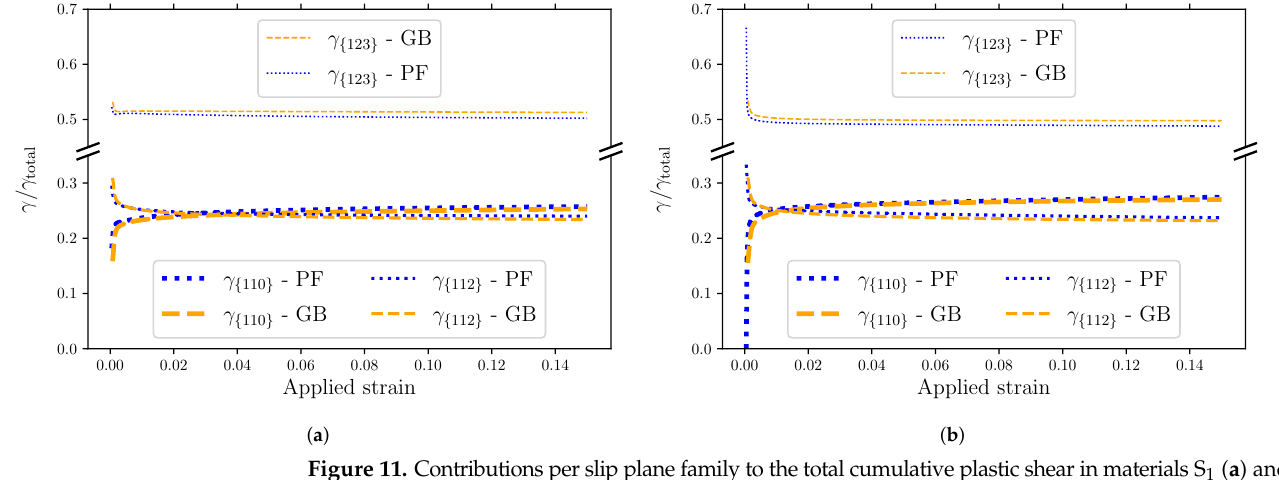
Figure 11. Contributions per slip plane family to the total cumulative plastic shear in materials S 1 ( a ) and S 2 ( b ). Polygonal ferrite is shown in blue and granular bainite is shown in